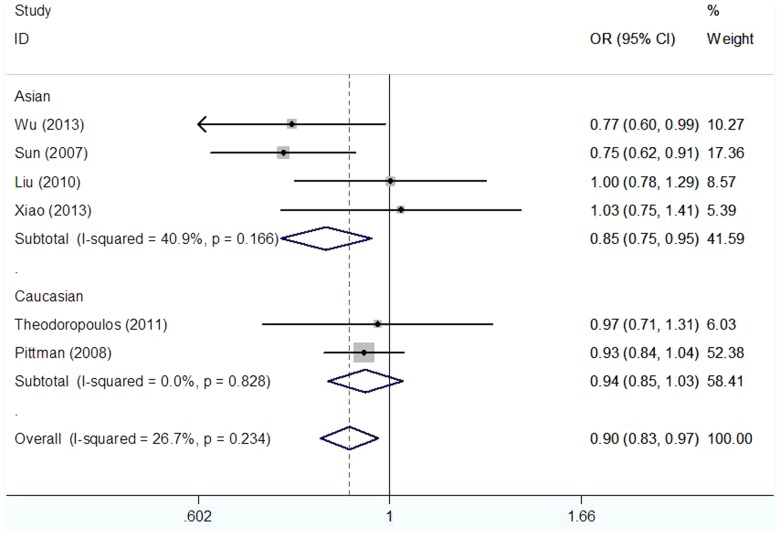
Forest plot of the CASP8 −652 6N del polymorphism and CRC risk using a fixed-effect model (additive model ins/del vs. ins/ins).